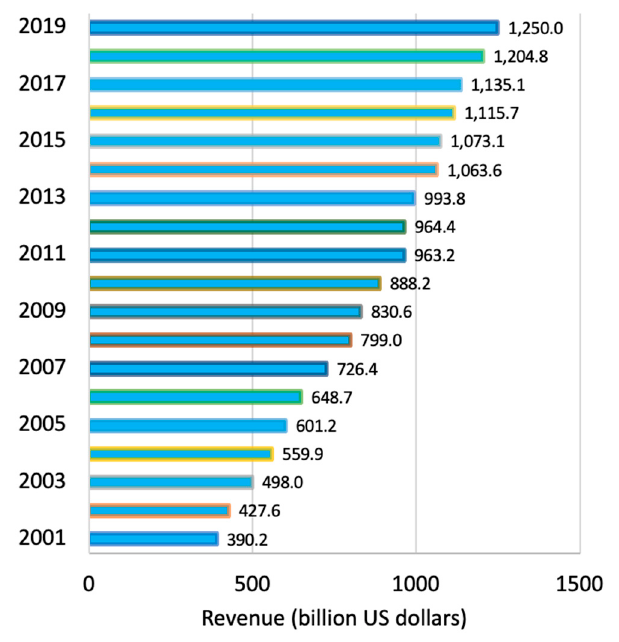
Figure 1. Global pharmaceutical revenue from 2001 to 2019 [83].